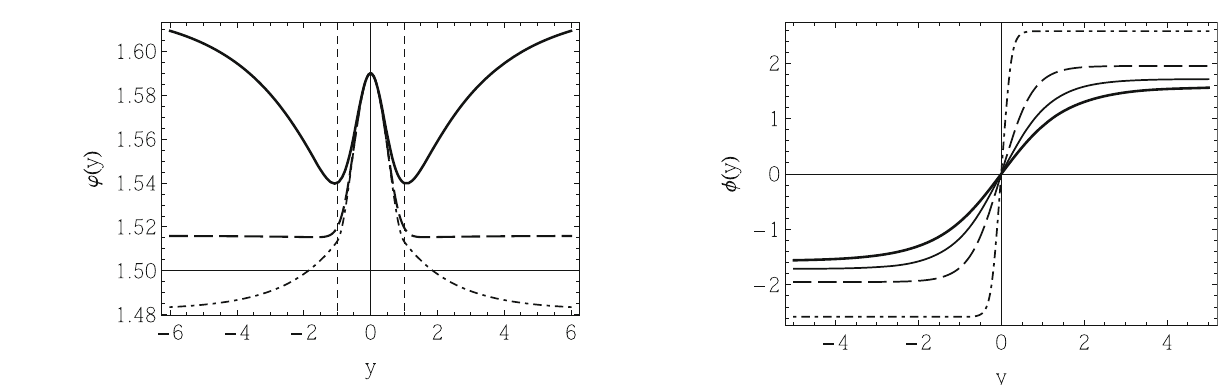
Fig. 12 Kink solution given by Eq. (37), plotted for λ = 0 (thick-solid line), λ = 0 . 3 (thin-solid line), λ = 0 . 6 (dashed line) and λ = 0 . 9 (dot-dashed